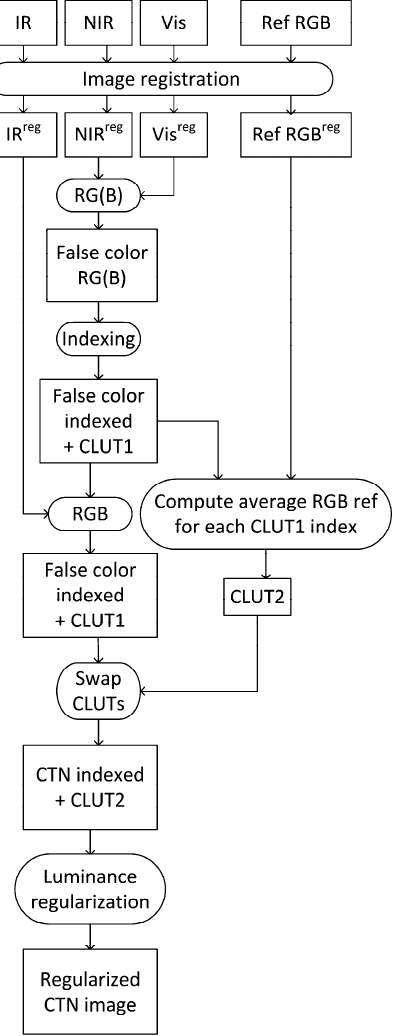
Figure 11. Processing scheme of the CTN2 sample-based color fusion method.